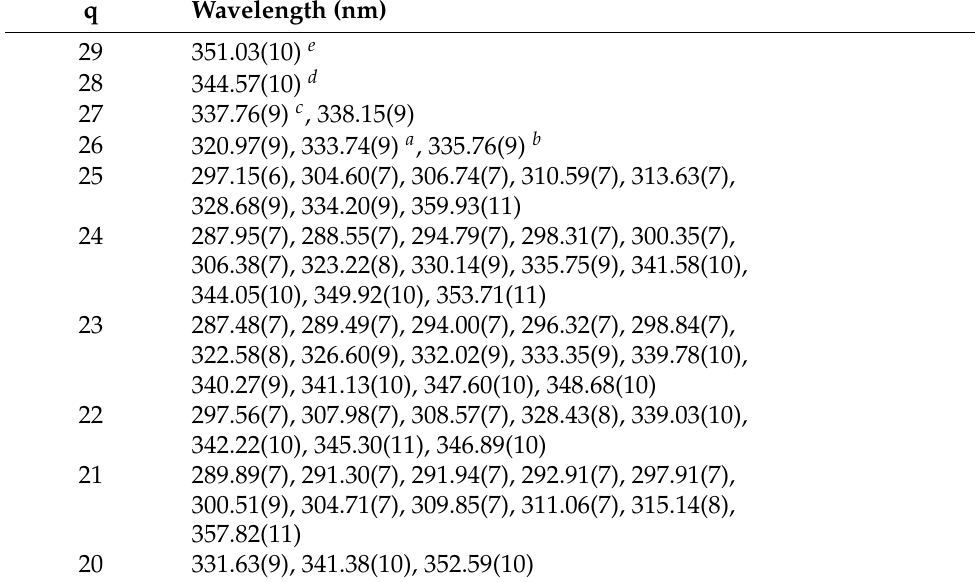
Table 1. Wavelengths (in air) of emission lines in 290–360 nm from W q + . Numbers in parenthesis are uncertainty. The superscript placed to the right of the wavelength indicates each emission line of a – e in Figure